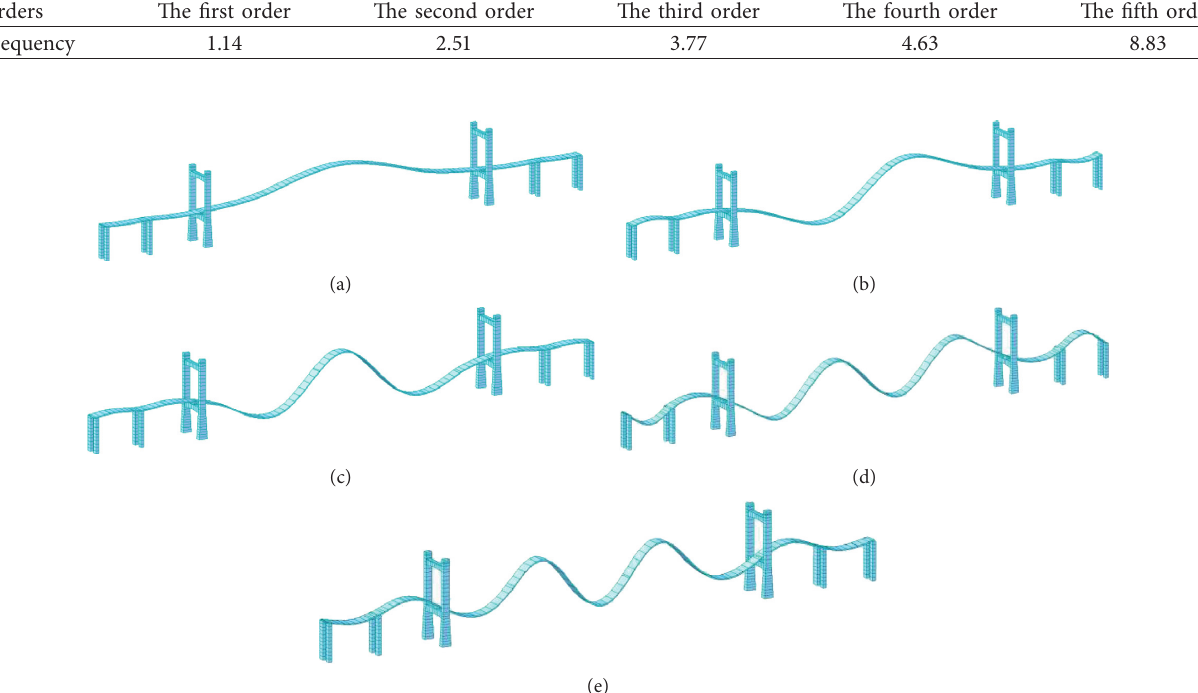
Figure 9: Modal shape of the first five orders (MIDAS). (a) Vertical bending mode of the first order ( f second order ( f 2 � 2.51Hz). (c) Vertical bending of the third order ( f 3 � 3.77Hz). (d) Vertical bending of the fourth order ( f 4 � 4.63Hz). (e) Vertical bending of the fifth order ( f 5 �